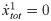
Flow diagram of Eq (10).As schematically indicated in the left-top panel, the nullclines are shown for x˙tot1=0 and x˙tot2=0 in blue and orange, respectively, and the crossing points of them are solutions. The directions of v1 = (1, 1) and v2 = (1, −1) are also indicated. For the solutions, stable fixed points are shown in red: those with stable growth [i.e., both fragments are in each subsystem] are in red circles, and those without growth [either of fragments is lost from subsystems or whole systems] are in red triangles. Unstable solutions are in light-blue squares, and neutral solutions in the v1-direction are in green stars at D = 0.02 (E). For D = 0 (A), the solution exists at (xtot1,xtot2)=(1/2,1/2) but it is unstable. For small values of D (B to D), the stable fixed points with growth [red circles] appear in addition to fixed points without growth. At D = 0.02 (E), the fixed points with growth get unstable [shown in green stars] in v1-directions. As D increases further (F), the two fixed points are still stable in v2-directions, while the solution at (xtot1,xtot2)=(1/2,1/2) is unstable in the direction. At D = 0.03125 (G), the system transits from the three fixed points to one fixed point.